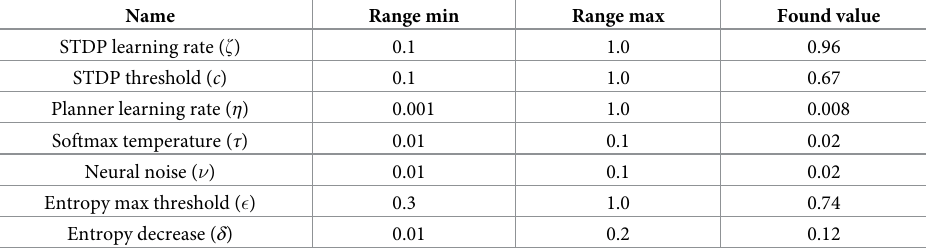
Table 1. Parameters identified with the grid search technique. In particular, parameter names, minimum and maxi- mum range, and values found by the